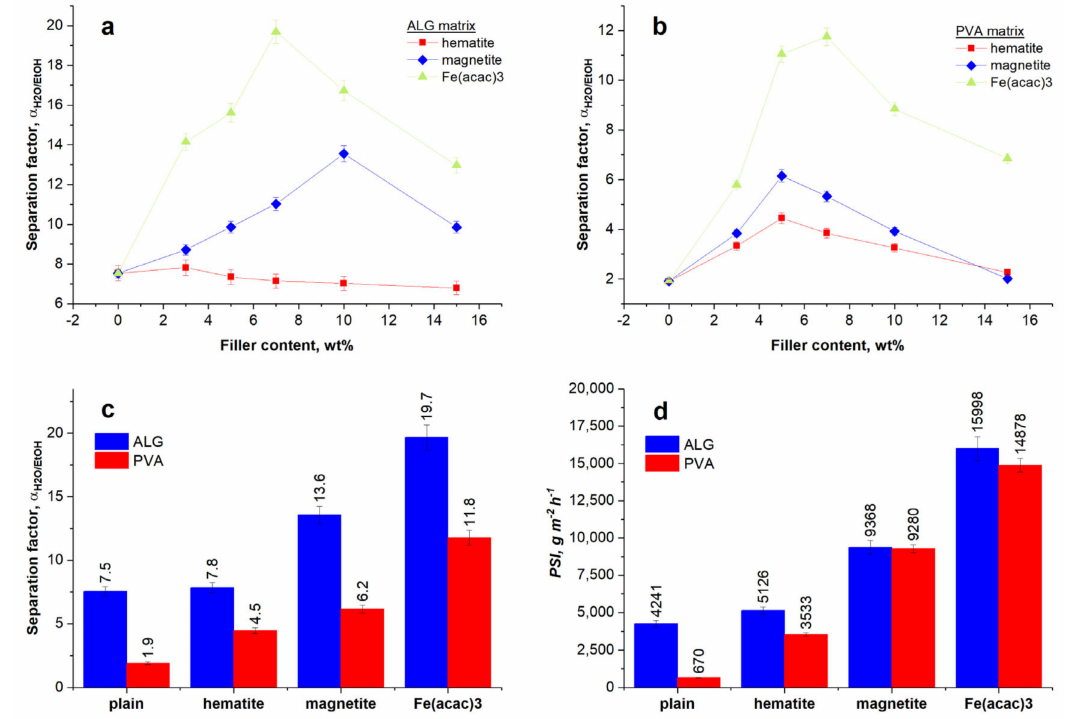
Figure 7. Changes of separation factor, α H ( b ) PVA membranes (symbols represent the experimental values and lines connect them only for visual guide); and the comparison of the maximum values of ( c ) α H polymer